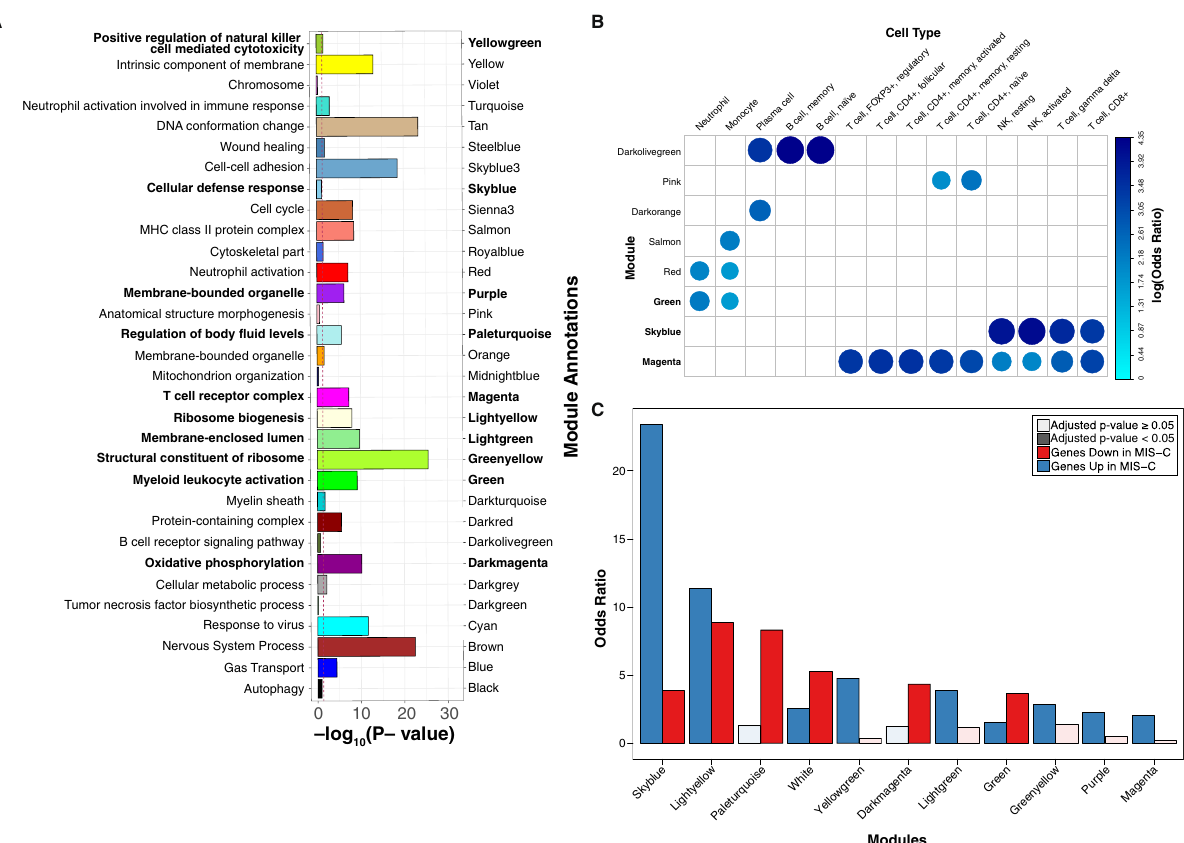
Fig. 3 Co-expression network analysis identi fi es modules of genes dysregulated in MIS-C. A Module GO term enrichments. The y -axis is the most signi fi cant GO term associated with each module, the x -axis is the − log 10 (adjusted p -value) for the enrichment (performed using Fisher ’ s test). Bars are colored by module names, which are also speci fi ed for clarity. Only modules with an enrichment p -value < 1 are shown. The threshold for signi fi cance, − log 10 (0.05), is indicated by the red dashed line. In bold lettering are the modules enriched for the MIS-C signature. B Module cell type signature enrichments. The x -axis and y -axis are the names of the modules and of the cell type signatures, respectively. All signatures shown here are derived from the LM22 reference (Newman et al. Nat. Methods , 2015). The color and size of the circles represents the log 2 (odds ratio) of the enrichments as de fi ned in the legend. In bold are the modules enriched for the MIS-C signature. Only enriched cell types are shown. C Modules enrichment for MIS-C signatures. The x -axis is the module names and the y -axis the odds ratio of the enrichment of the modules for the genes upregulated and downregulated in MIS-C. Only modules signi fi cantly enriched for MIS-C DEGs are shown. The color of the bars represent direction and the opacity represent the signi fi cance as de fi ned in the legend. All p -values were adjusted for multi-testing as described in the “ Methods ” section. All module enrichments can be found in Supplementary Data 7, 9 – 12,